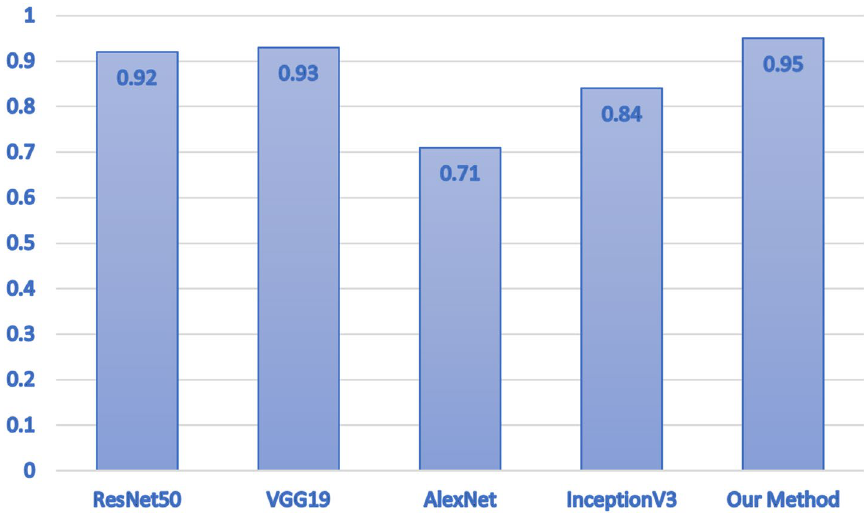
Figure 4. The comparison in terms of accuracy obtained by the state-of-the-art models and the proposed deep learning